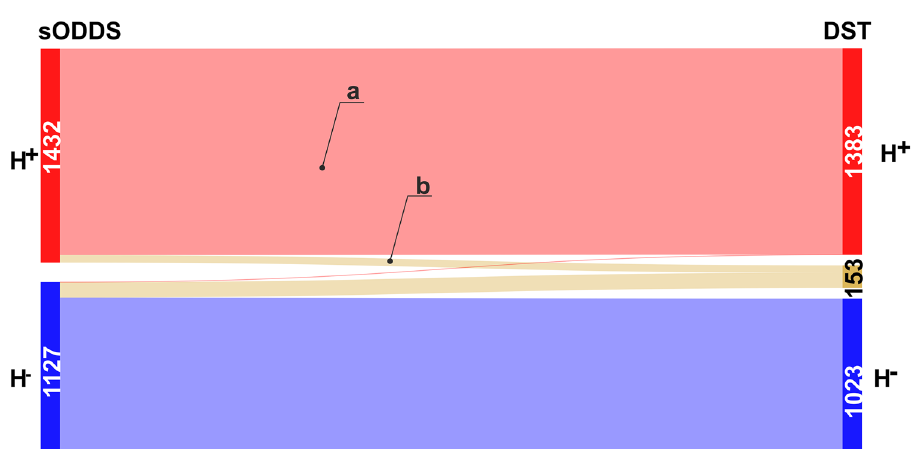
Figure 7. Alluvial flow diagram for patients originally diagnosed by ODDS and then checked by DST. Left margin: Hormone receptor assessed by method sODDS: positive (H + ) and negative (H − ). A sample was considered H + if at least one receptor was positive. Lacking IHC estimates were imputed by ODDS and included only if imputation was safe, otherwise discarded. Hence, no patients with receptor status ‘undetermined’ appear in dataset subjected to DST. Right margin: Evaluation by DST confirms the vast majority of estimates from sODDS but leaves some 153 as undetermined (ochre colored). Only one patient is definitely considered false negative and changed to